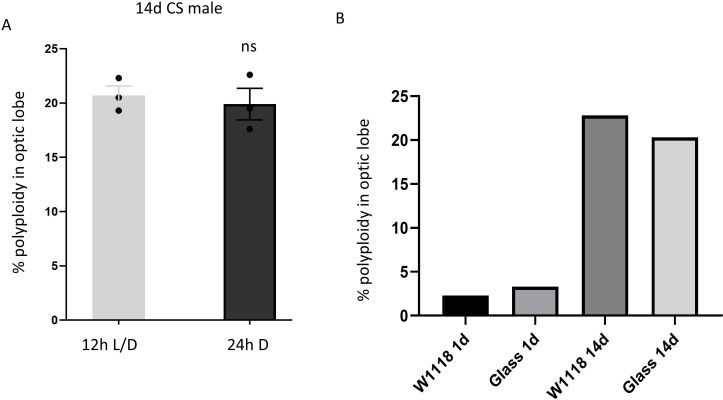
Polyploidy in Optic lobes is not light or photoreceptor dependent.(A) 14d Canton-S (CS) males reared in 12 h L/D cycles do not show significantly different polyploidy compared to age-matched CS males reared in 24 hr darkness from eclosion. Error bars = mean ± SEM; unpaired t-test with welch’s correction. (B) Percentage of polyploidy observed in glass60j mutants lacking photoreceptors and age-matched w1118 controls at 1 and 14 days. Bars show mean % polyploidy in samples containing three pooled brains.